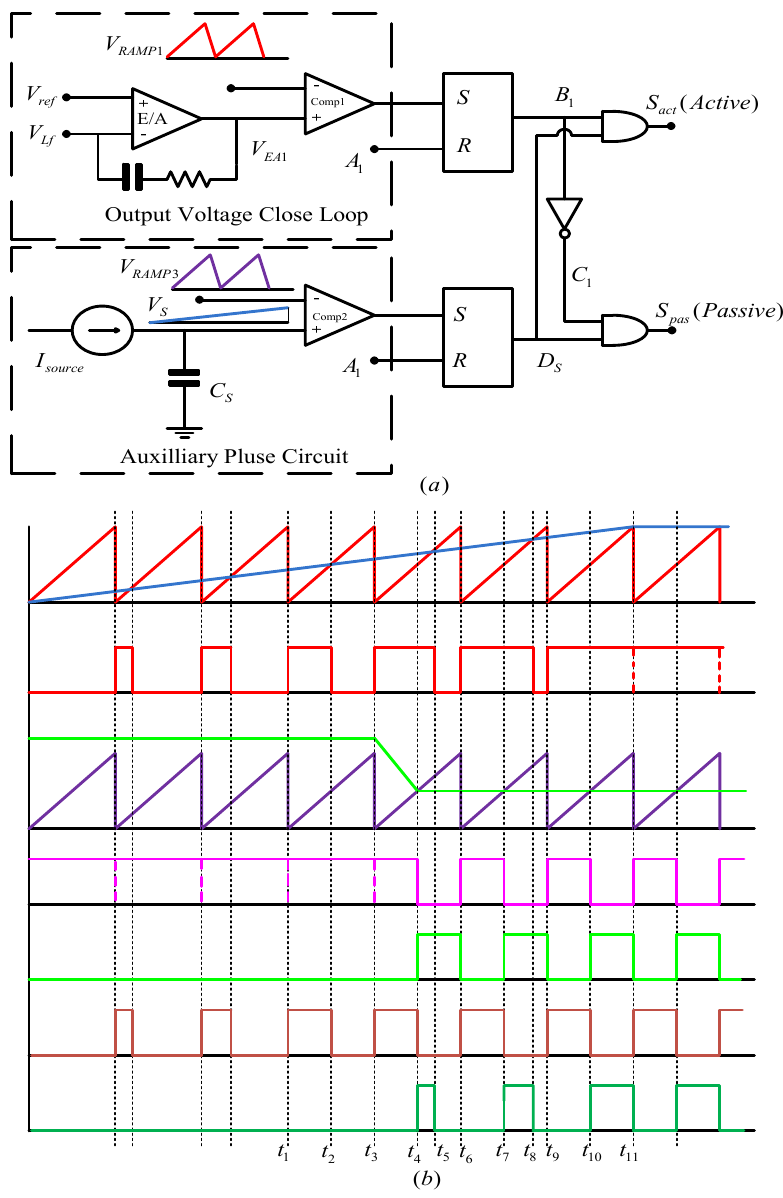
Figure 15. New Bidirectional soft-start control strategy for hybrid power sources.